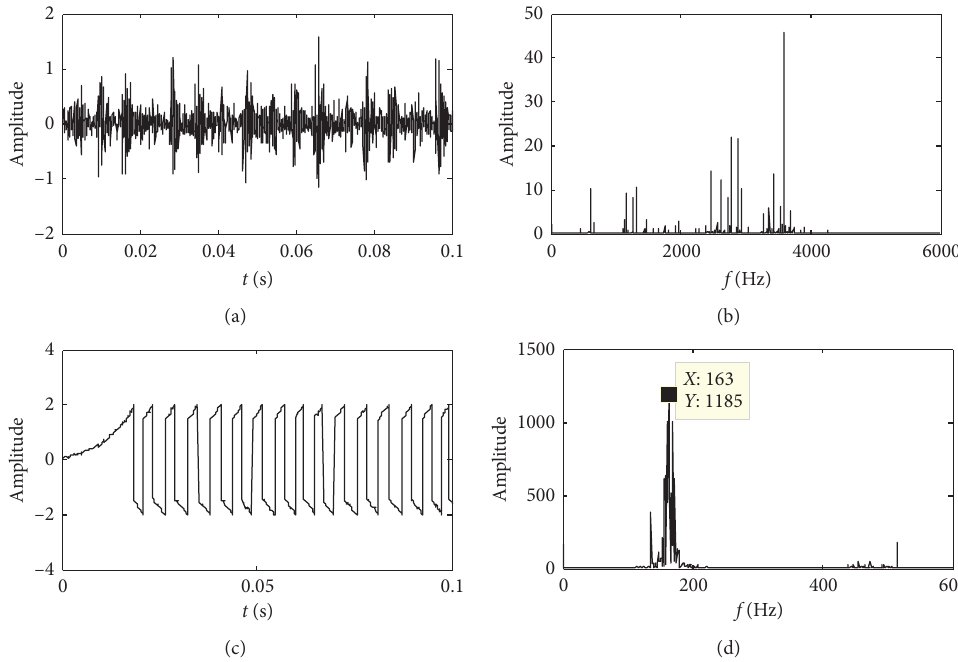
Figure 10: Time-domain and frequency-domain diagrams of the input and output of inner-loop fault detection system ( a � 1 . 263827550905825 ,b � 1 . 226069 , r � 1 ,c � 0 . 253128458753468 ) .